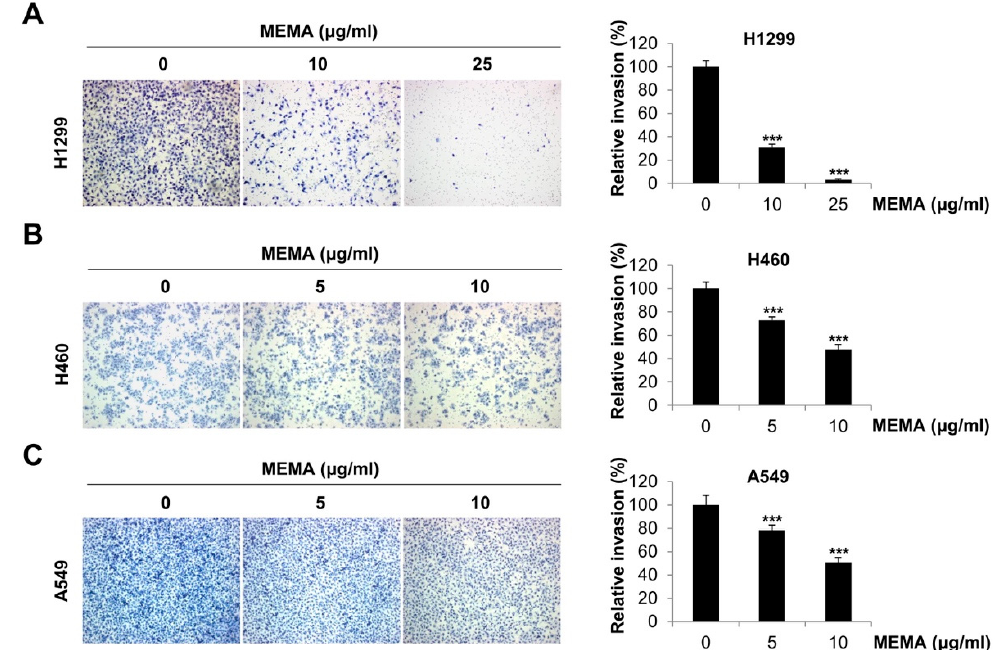
Figure 4. Effects of MEMA on the invasion of human NSCLC cells. Transwell invasion assay was conducted in H1299 ( A ), H460 ( B ), and A549 ( C ) cells. Cells were plated into the matrigel-coated upper chamber of a 24-well format transwell plate and challenged with MEMA. Ten percent FBS medium was used as a chemoattractant. After 24 h of incubation, cells that invaded through the membrane were stained and photographed under microscope (100 × magnification). The representative fields of three independent experiments are shown (left panel). The relative invasion was evaluated by counting the number of stained cells (right panel). The data were expressed as the mean ± SD of three independent experiments. Significance was determined by the Student’s t -test (*** p < 0.001 versus untreated controls).